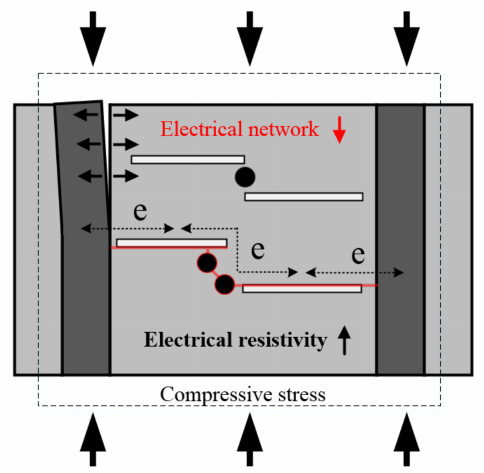
Figure 14. Cracking behavior of electrodes in surface under